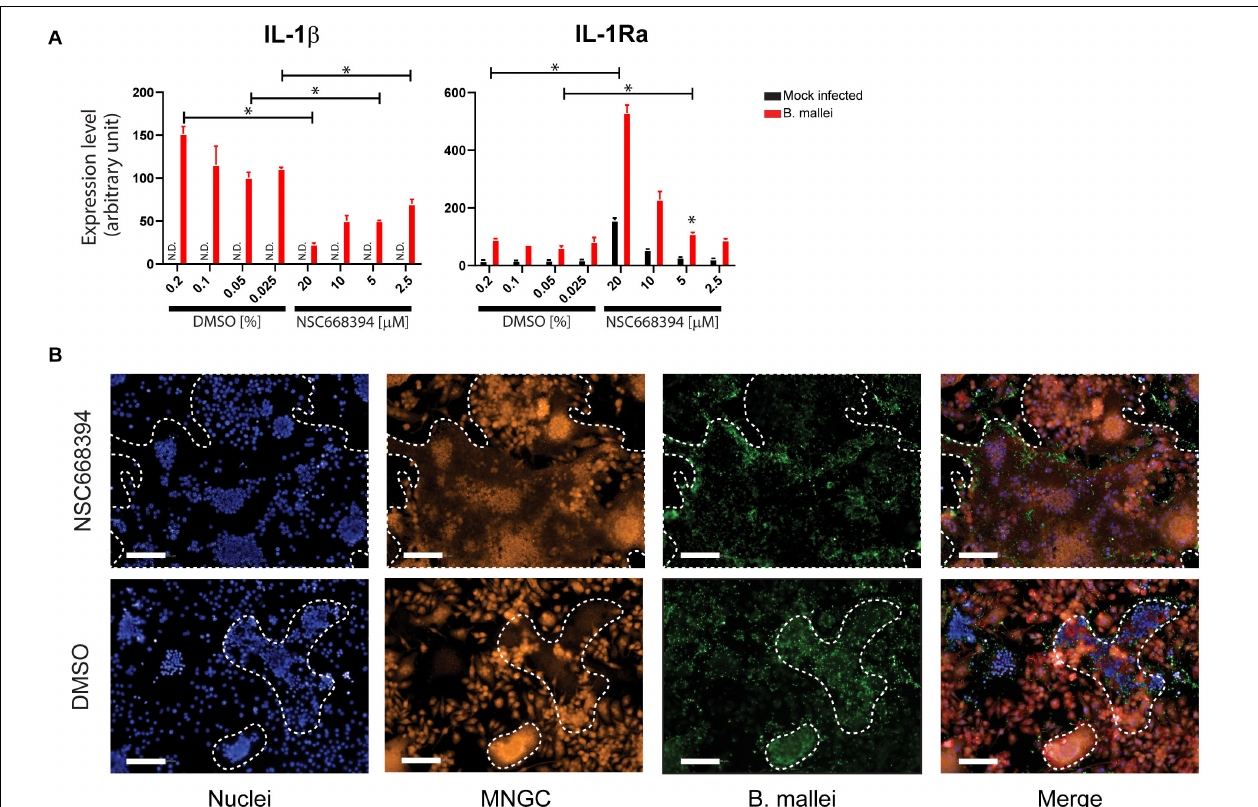
FIGURE 5 | Ezrin modulates B. mallei mediated pro-inflammatory responses. (A) Two hours before B. mallei infection (MOI = 1), mBMDMs were pretreated with ezrin inhibitor at indicated concentrations. Total RNAs were extracted 5 h post infection and the expression level of indicated genes were quantified by real-time PCR. N.D. indicates not detected. “ ∗ ” denotes p < 0.05. (B) Two hours before B. mallei infection (MOI = 1), RAW264.7 macrophages were pretreated with ezrin inhibitor (10 µ M, images shown). The cells were fixed 16 h post infection. Orange stain: cytoplasm; Green stain: B. mallei ; Blue stain: nuclei. The MNGC formation is traced in white. (Data representing two biological replicates which include 6 analytical